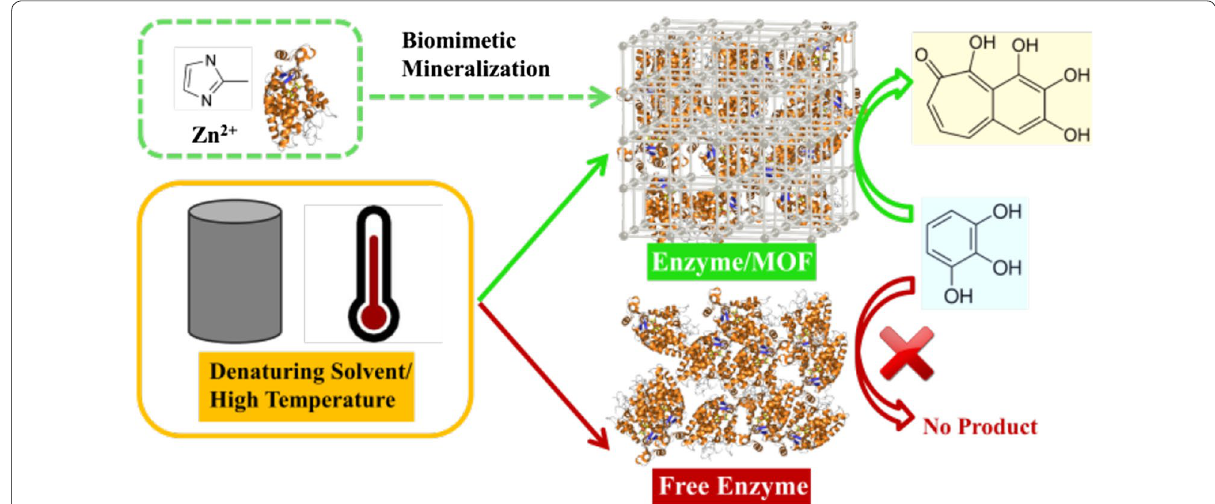
Fig. 1 Scheme of the green synthesis of enzyme-MOF composites exhibiting tolerance for denaturing solvents and